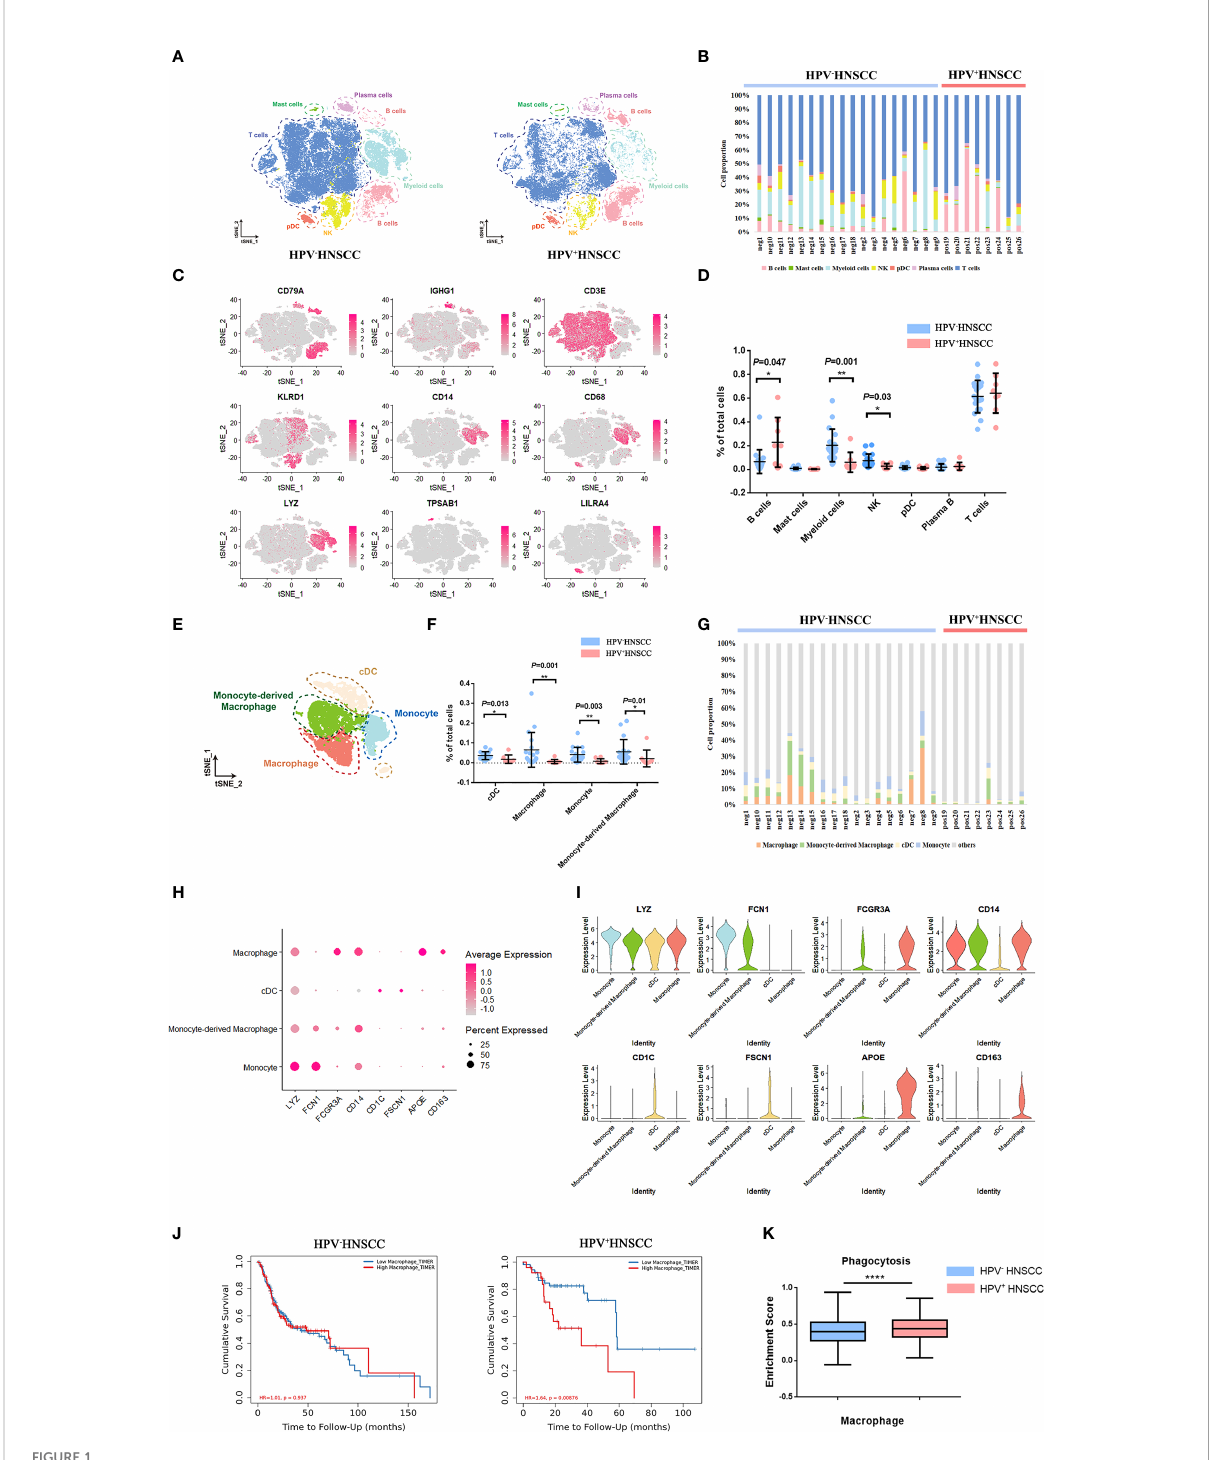
FIGURE 1 Single-cell atlas of HPV-related HNSCC. (A) The t-SNE plot of high-quality cells in HPV - (left) and HPV + (right) HNSCC. pDC, plasmacytoid dendritic cell. NK, natural killer cell. (B) The proportion of immune cells in each sample. (C) The feature plot of the feature gene distribution. (D) The frequency of immune cell clusters. HPV + HNSCC (n = 8), HPV - HNSCC (n = 18). (E) The t-SNE plot of myeloid cells in HPV-related HNSCC. cDC, classical dendritic cell. (F) The proportion of myeloid cell subsets. (G) The frequency of macrophages and monocyte-derived macrophages in each sample. (H, I) The bubble charts and violin plot of classical markers indicating group identities. (J) Prognosis analysis of HPV +/- HNSCC patients from TCGA datasets calculated by TIMER2. HPV + HNSCC (n = 98), HPV - HNSCC (n =422). (K) The expression of phagocytosis signatures in macrophage across HPV +/- HNSCC patients. * P < 0.05, ** P < 0.01, **** P <